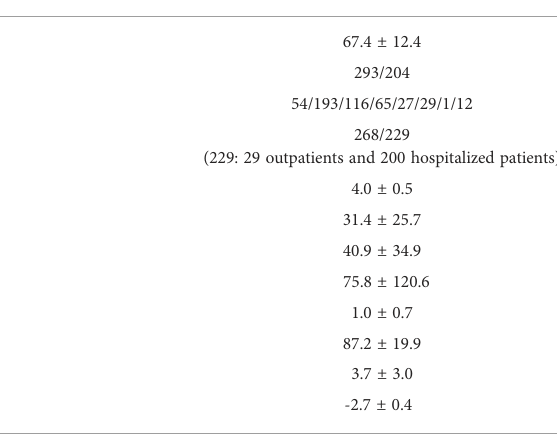
TABLE 1 All patient